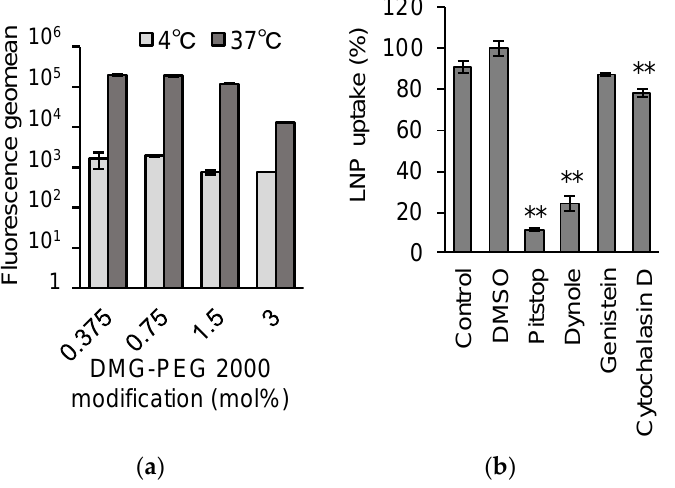
Figure 6. Uptake mechanism of the LNP ssPalm . ( a ) The effects of temperature. The Jurkat cells were incubated with the LNP ssPalm at 37 °C or 4 °C. The cellular uptake was evaluated by flow-cytometry. Data are represented as the mean ± SD ( n = 3). ( b ) pharmacological inhibition of the endocytosis. The Jurkat cells were incubated with LNP ssPalm in the presence of pharmacological inhibitors of endocytosis pathways. As inhibitors, 30 µ M Pitstop ® 2 (clathrin inhibitor), 20 µ M Dynole ® 34-2 (dynamin inhibitor), 100 µ M Genistein (tyrosine kinase inhibitor), and 10 µ M Cytochalasin D (actin inhibitor) were used. Data were represented as mean ± SD ( n = 3). Statistical analyses were performed by Scheffe’s F multicomparison test ( n = 3), **; p < 0.01.